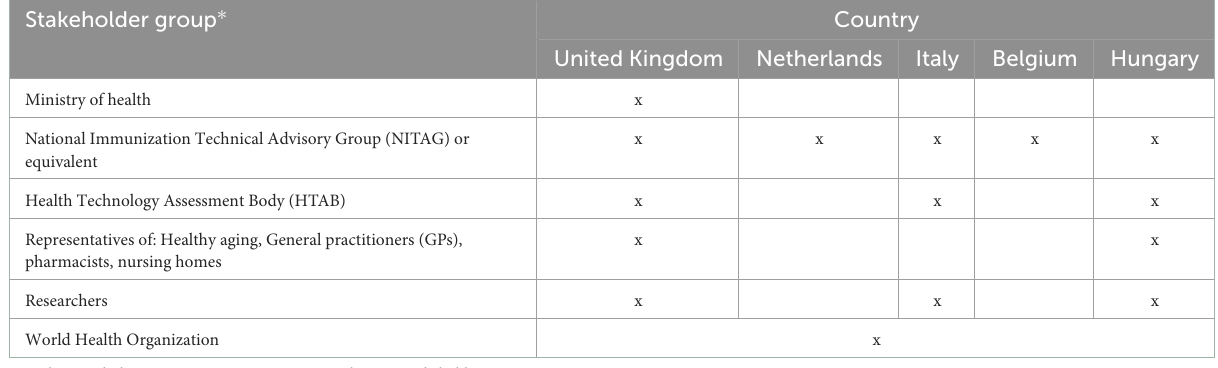
TABLE 2 Description of the Delphi panel.